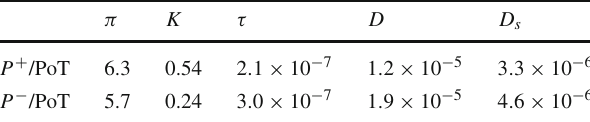
Table 3 Average number of positive and negative parent mesons and τ leptons P per PoT produced in the